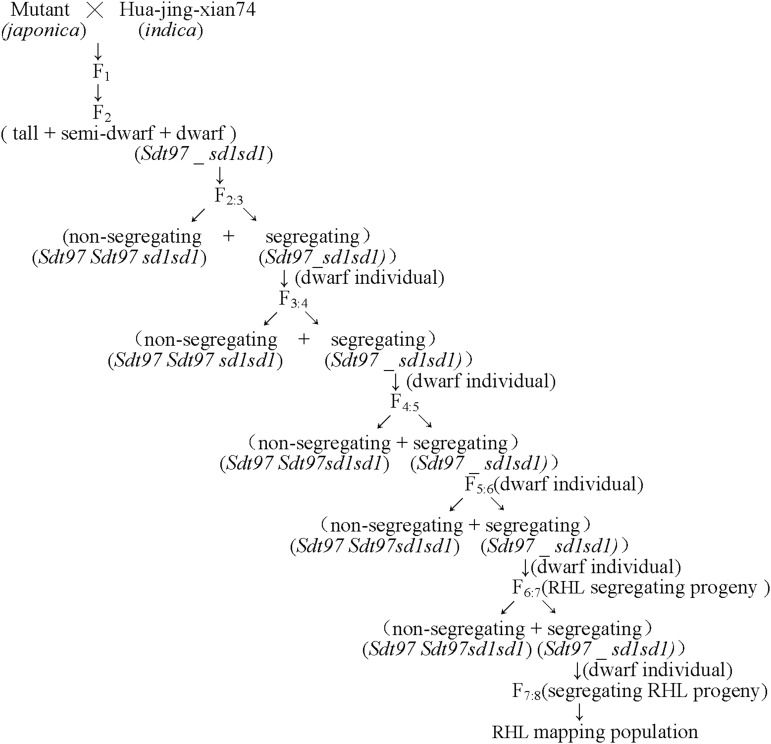
Development of the RHL mapping population.